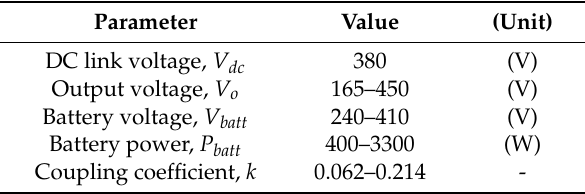
Figure 1. Schematic of a 3.3 kW IPT system. Table 1. Specifications of the IPT system.